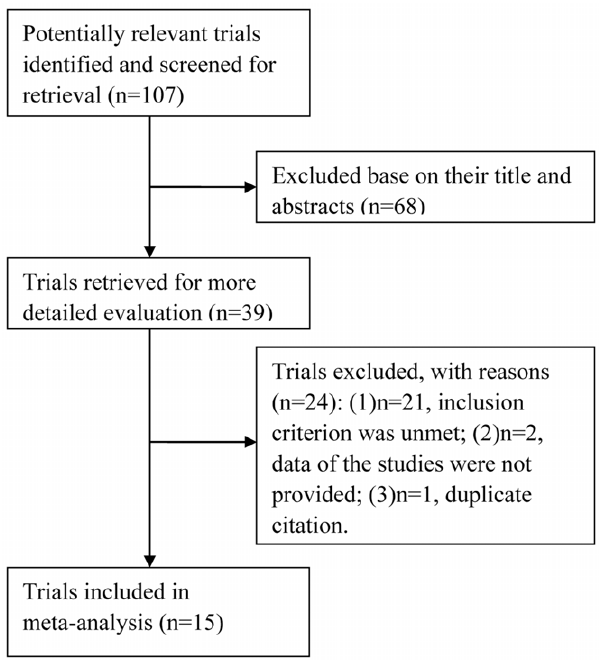
Figure 1. Process of study selection of RCTs.